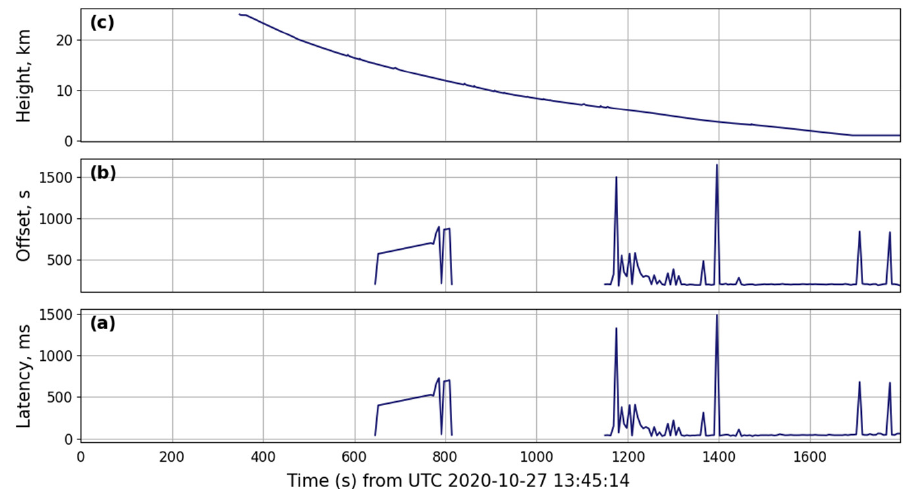
Figure 7. Timing synchronization framework showing ( a ) the estimated round-trip sync exchange latency in milliseconds, ( b ) the station clock offset correction from the reference clock in seconds, and ( c ) location height above ground in km.